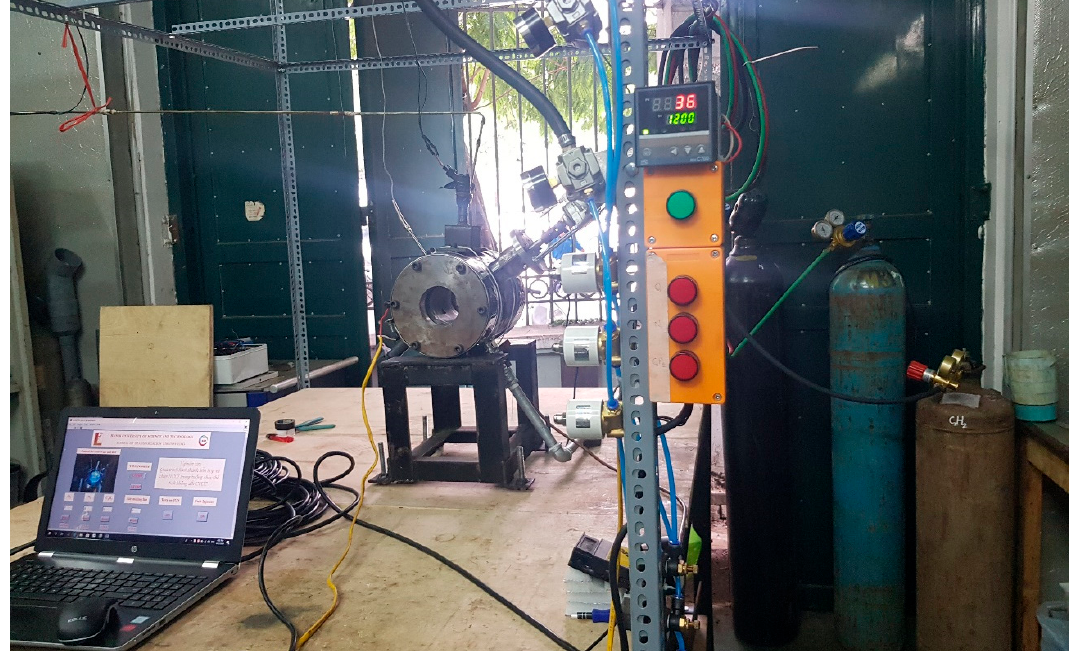
Figure 3. Constant volume combustion chamber.